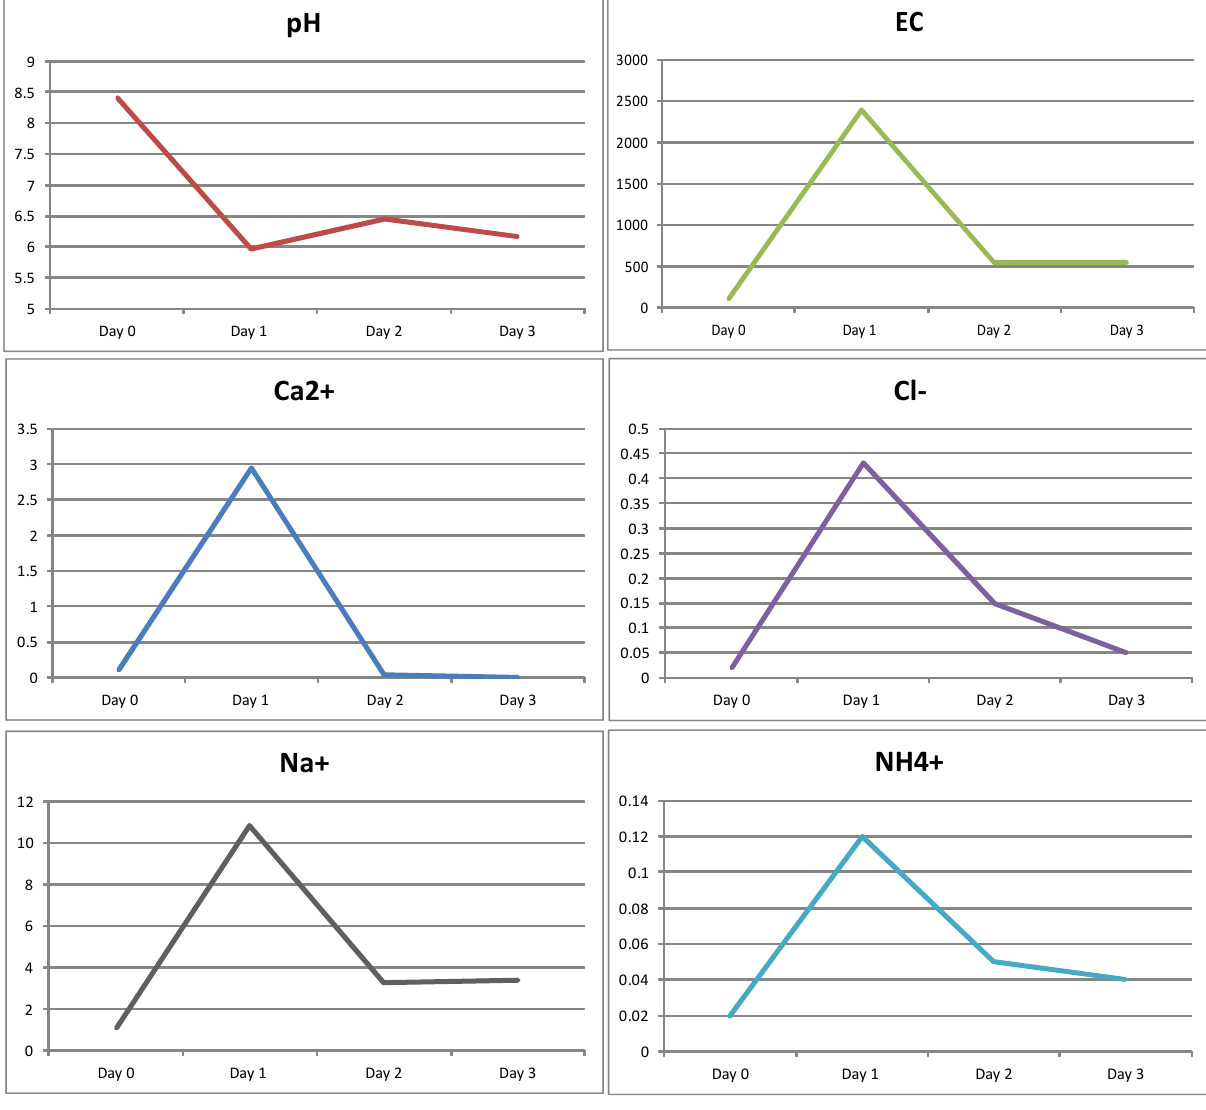
Figure 14. pH, EC and concentrations of various nutrients during a typical nutrient cycle: before nutrients are added or replenished (day 0) and after (day 1). Most nutrients are absorbed within one day (by day 2), depending on the pH.